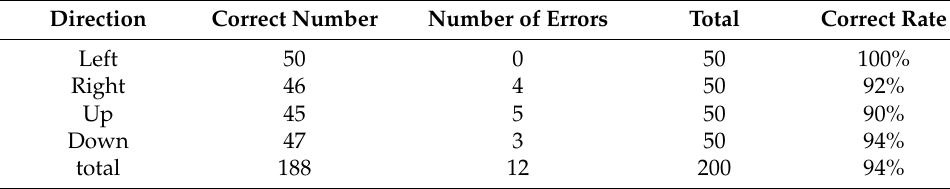
Table 5. Recognition results of direction input.